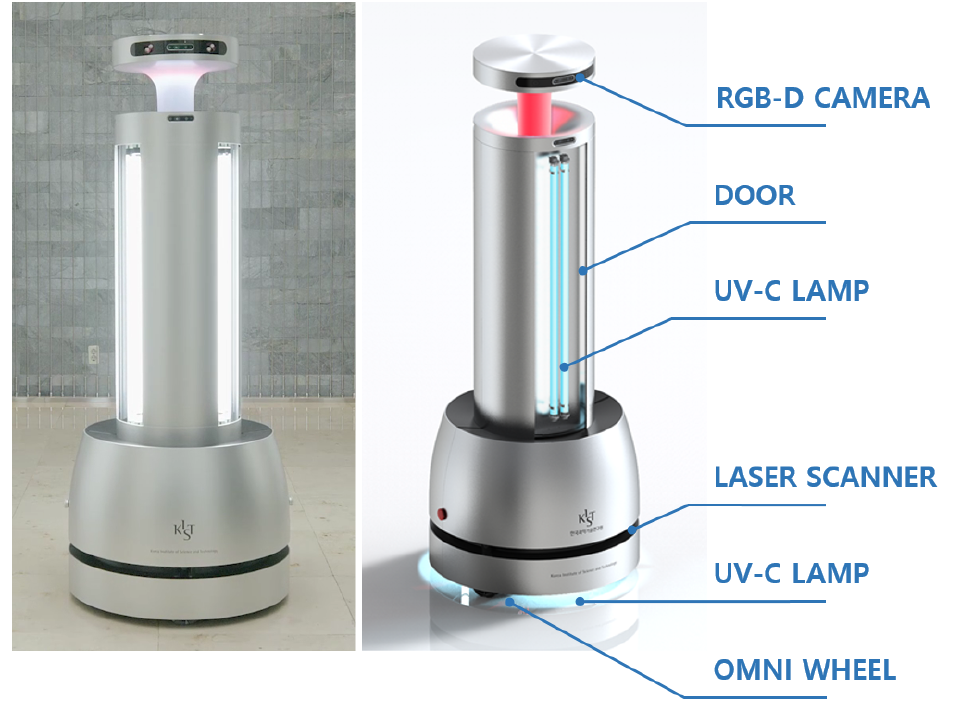
Figure 1. AIDBOT